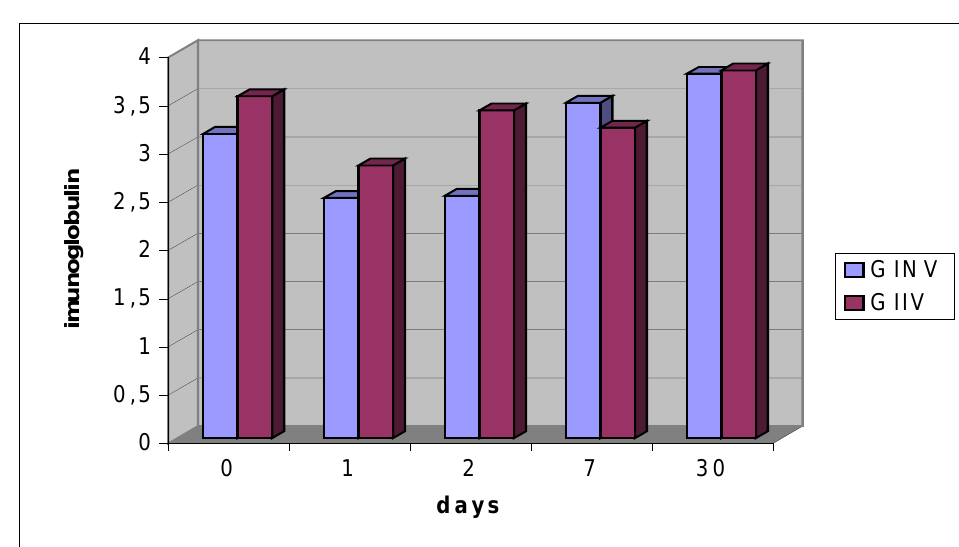
Figure 7. Mean values of total immunoglobulin (g/dl) in animals of the group inoculated with natural venom (GINV) and the group inoculated with irradiated venom (GIIV) before and after venom